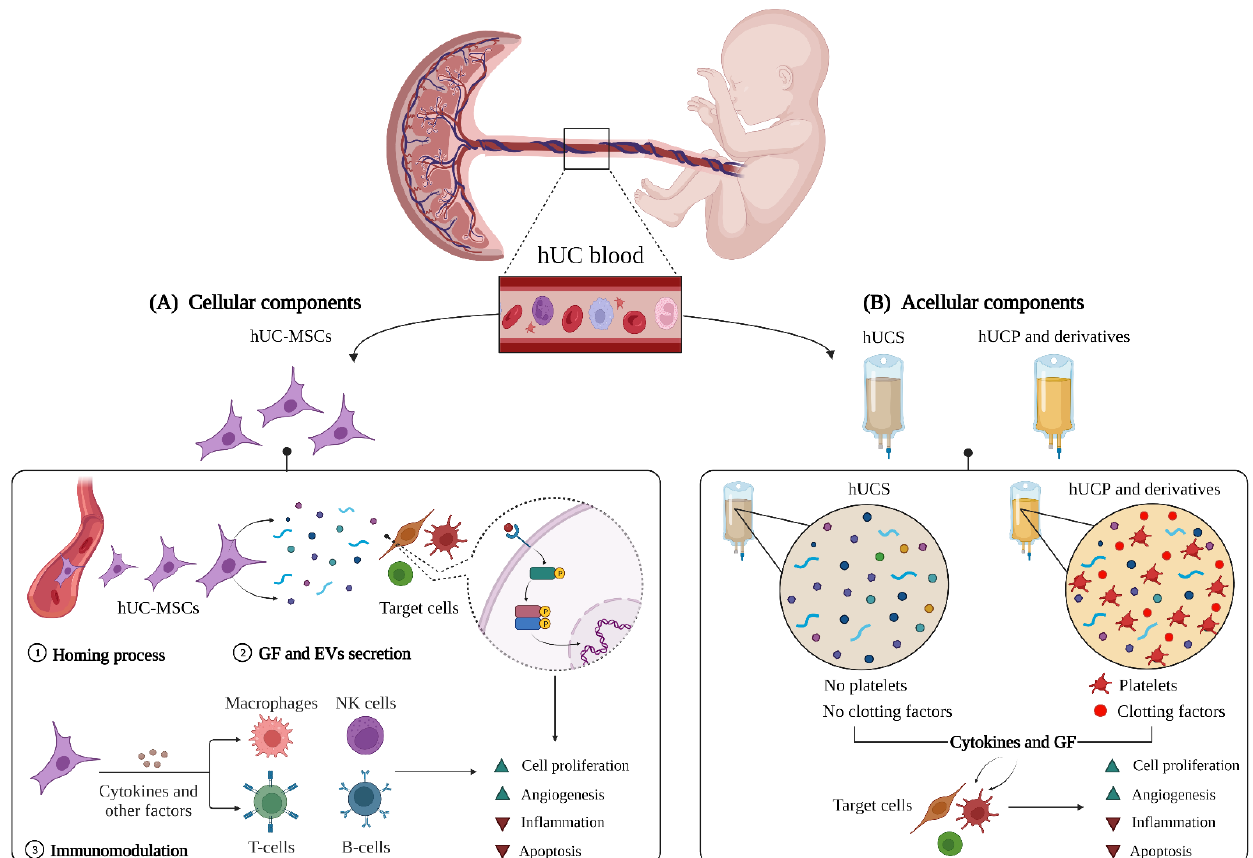
Figure 1. The hUC blood composition. This illustration depicts the roles of the ( A ) cellular and ( B ) acellular components, in tissue regeneration processes. EVs, extracellular vesicles; GF, growth factors; hUC, human umbilical cord; hUC-MSCs, human umbilical cord mesenchymal stem cells; hUCP, human umbilical cord plasma; hUCS, human umbilical cord serum; and NK cells, natural killer